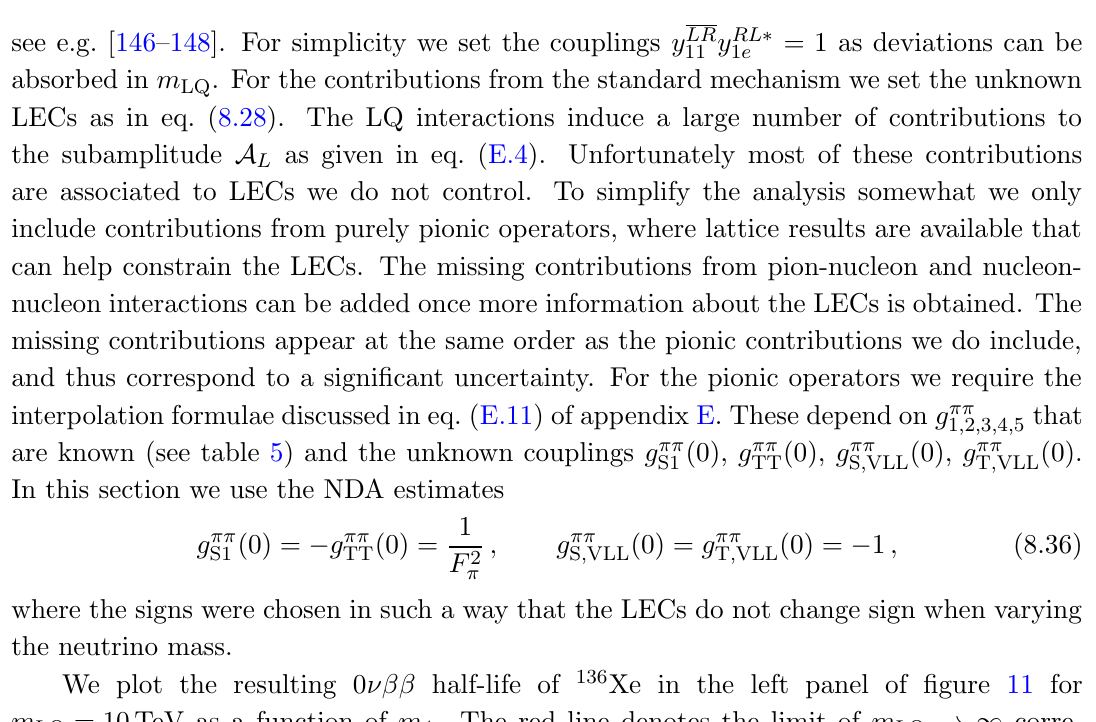
Figure 11 . Left panel: T 0 (cid:23) ( 136 Xe) as a function of m 4 in the LQ 3 + 1 model. The blue line is 1 = 2 the total half life whereas the red line depicts the contribution from just the standard mechanism (exchange of neutrinos interacting via left-handed currents). We have set y LR m LQ = 10 TeV. Right panel: similar but now we (cid:12)xed m 4 = 10 eV (blue), m 4 = 1 keV (red), and m 4 = 5 GeV (green) and vary m LQ . In both panels the Dirac and Majorana phases were set to p zero, m 3 = (cid:1) m 2 , and the QRPA NMEs were ATM